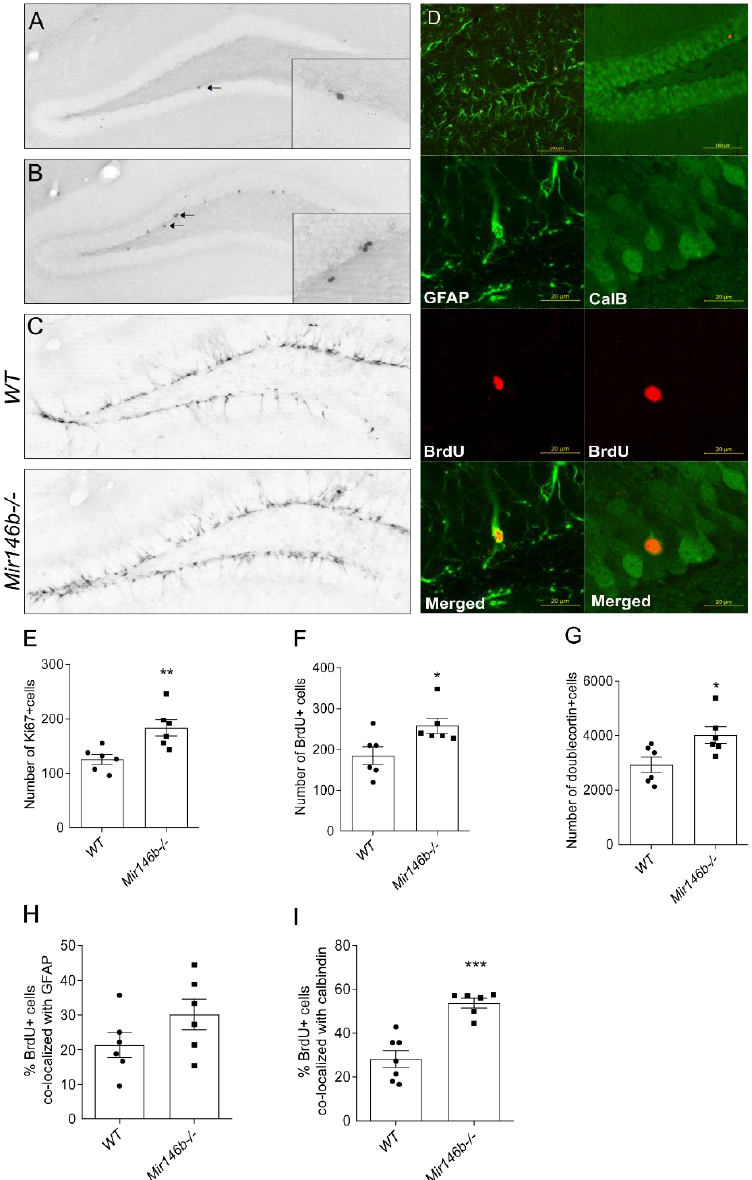
Figure 5. Increased adult hippocampal neurogenesis in Mir146b -/- mice. ( A ) Representative immuno- histochemistry microphotographs of the hippocampal Ki67+ cells at 100 × magnification and inserted microphotographs at 1000 × magnification. ( B ) Illustrative microphotographs of the hippocam- pal BrdU+ cells at 100 × magnification and inserted microphotographs at 1000 × magnification. ( C ) Represented microphotographs of doublecortin positive cells taken at 100 × magnification. ( D ) Illustrative images of BrdU, GFAP and calbindin signal and their co-localization in the hip- pocampus. ( E ) Quantitative graph showing increased number of Ki67 positive cells. ( F ) Increased number of BrdU+ cells. ( G ) Quantitative graphs showing number of doublecortin positive cells in the hippocampus of WT and Mir146b -/- mice. ( H ) Percentage of BrdU+ cells with GFAP and ( I ) calbindin in the dentate gyrus of WT and Mir146b -/- mice. Scale bar = 20 µ m. Number of animals = 6, Student’s t -test. Data represented as mean ± SEM; * p < 0.05, ** p < 0.01, *** p <